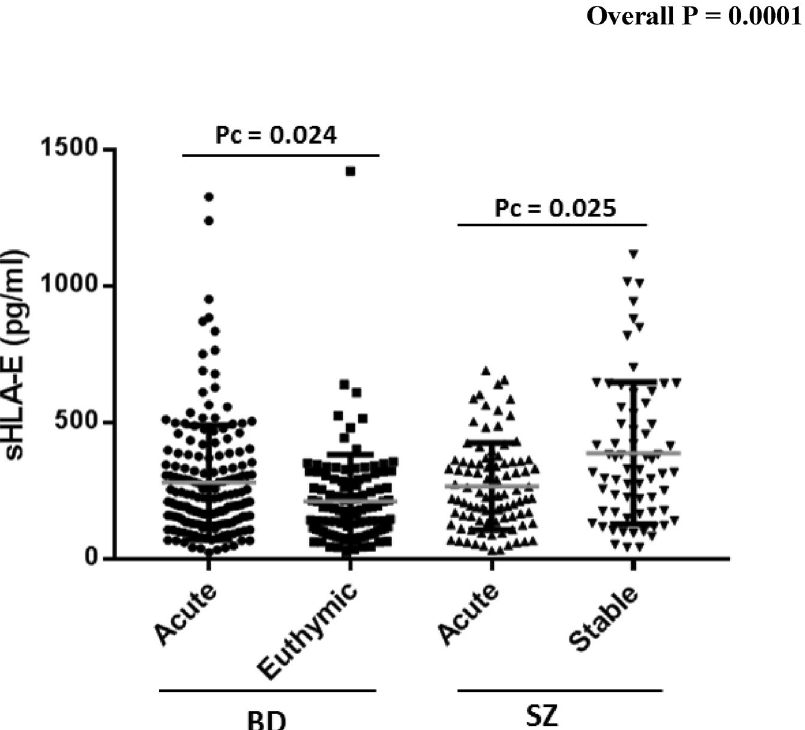
Figure 3. Analysis of sHLA-E distribution according to acute and stable phase of SZ or BD (265.14 vs. 387.05, pc = 0.025 in acute and stable SZ patients respectively) and (278.9 vs. 232.48, pc = 0.024 in acute BD episode and euthymic phase respectively). p value was corrected using the Bonferroni test.